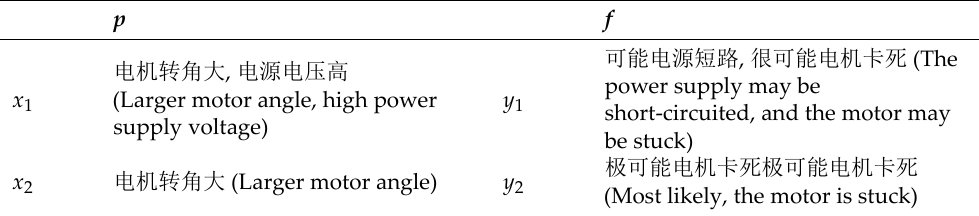
Table 9. Sorted rule set.